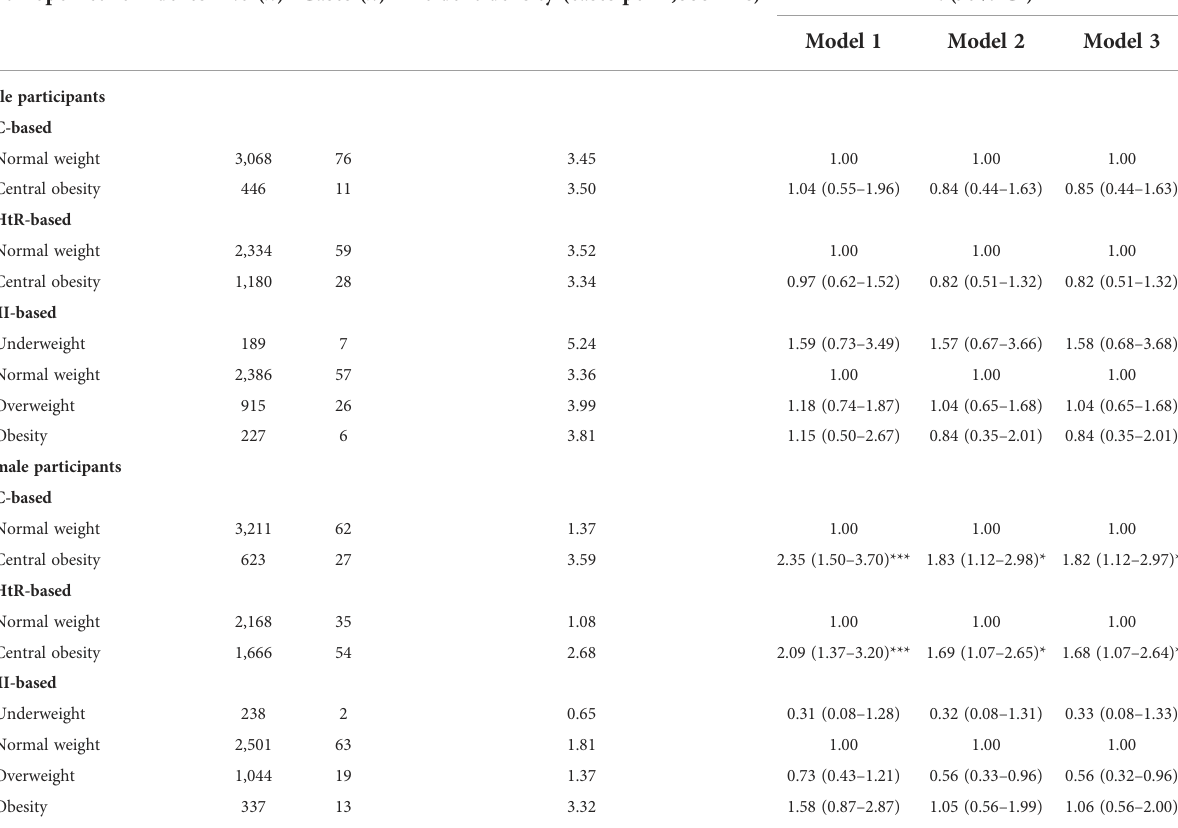
TABLE 2 Hazard ratios (HRs) and 95% con fi dence intervals (95% CIs) for overall CVD associated with adiposity category among male ( n = 3,717) and female ( n = 4,120) participants according to Cox regression models.